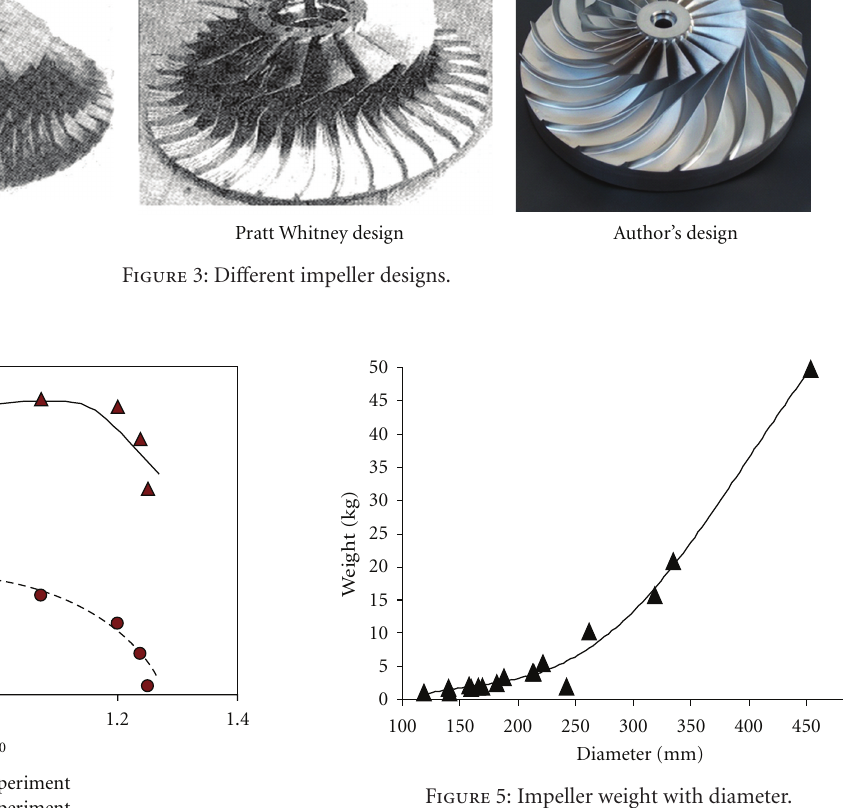
Figure 4: Single stage compressor e ffi ciency and head coe ffi cient versus flow coe ffi cient (upper curve is the adiabatic e ffi ciency, and lower curve is head coe ffi ciency).